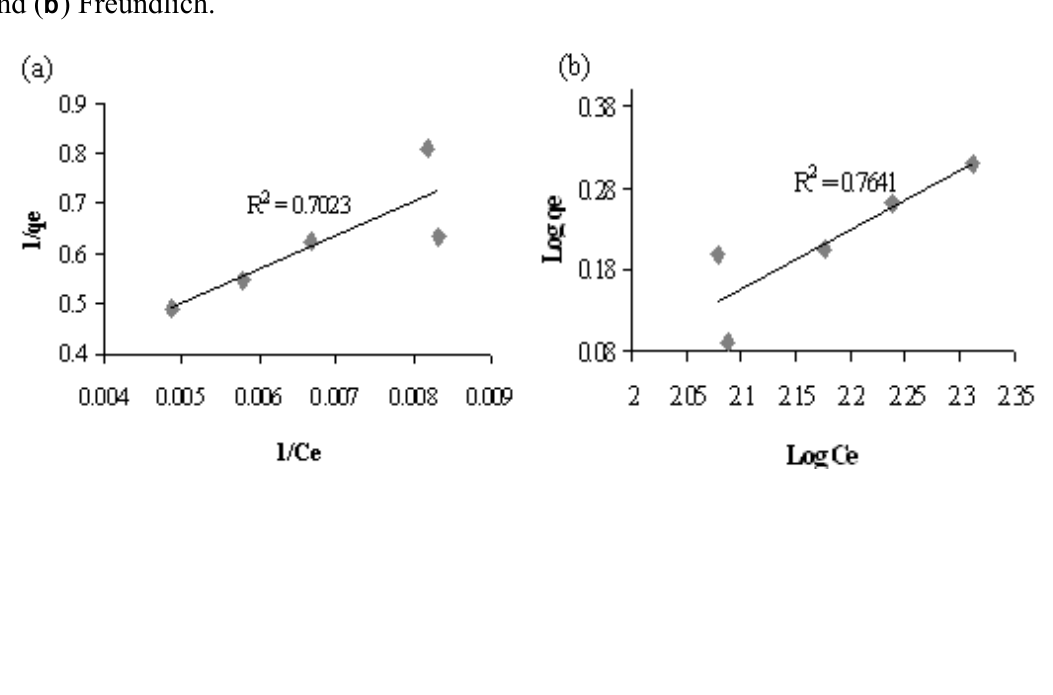
Figure 4 . Adsorption isotherm for ammoniacal nitrogen onto silica sand: ( a ) Langmuir, and ( b )